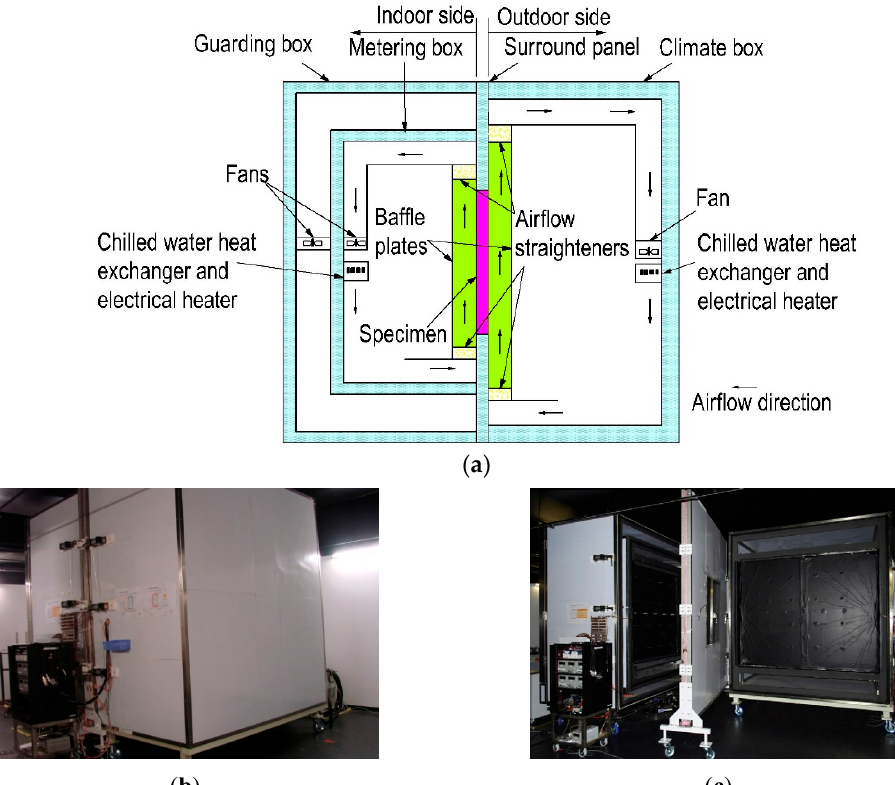
Figure 5. Calorimetric hot box (CHB) system: ( a ) schematics of the CHB (Chen et al. 2012a) [20]; ( b ) closed hot box; ( c ) opened hot box (Chen et al. 2012a) [20] .